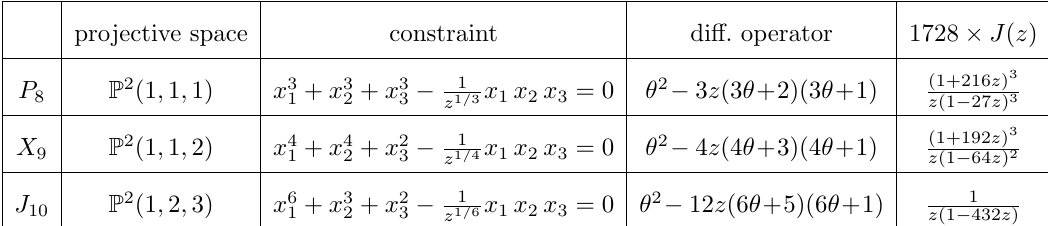
Table 3 . List, from [108], of three realizations of elliptic curves as hypersurfaces in weighted projective spaces. Here (cid:18) is the di(cid:11)erential operator (cid:18) (cid:17) z@ z . These same examples appear in Arnold’s classi(cid:12)cation of normal forms of functions with unimodular parabolic singularities [114]. potential (in Chebyshev form) Chebyshev m hypergeometric operator J ( u ) identi(cid:12)cation